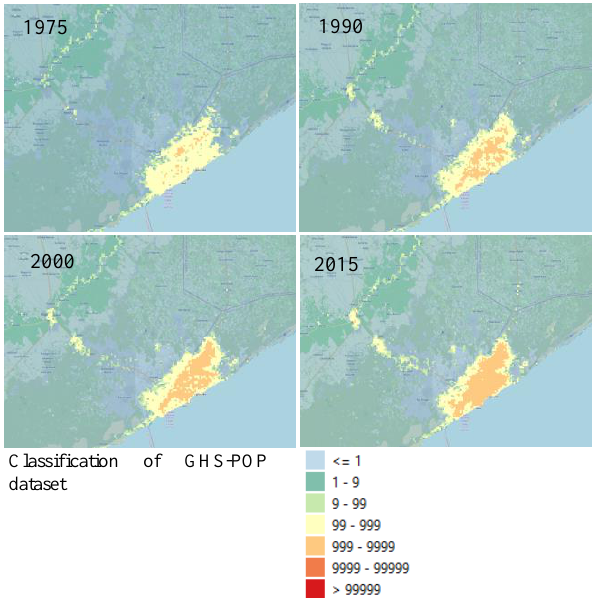
Figure 7. GHS-POP Population data (Schiavina, 2019) for 1975, 1990, 2000 and 2015.